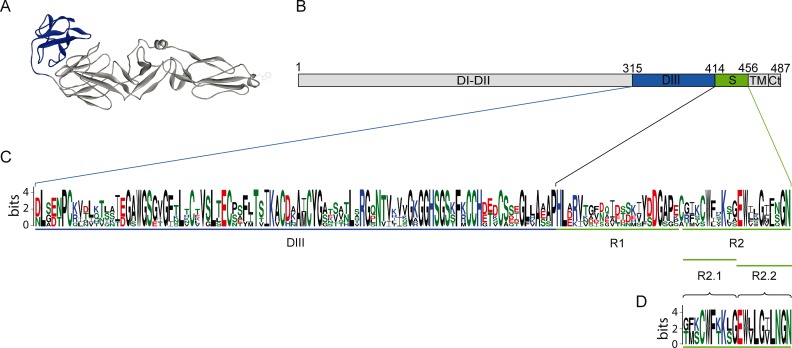
Localization of predicted DIII and stem fragments in ANDV Gc.(A) Molecular model for ANDV Gc in its pre-fusion conformation [23] based on the TBEV E protein (PDB: 1SVB) [31]. The predicted DIII is indicated in blue and the predicted domains I-II are shown in grey. (B) Scheme of the ANDV Gc primary structure indicating predicted residues for DIII (blue) and the predicted stem region (green). S indicates the stem region; TM indicates the transmembrane region; Ct indicates the cytoplasmic tail. (C) Sequence logo representation of a multiple sequence alignment including DIII and stem regions of the genus Hantavirus built with WebLogo [65]. The sequence conservation at each position is represented by the overall height of the stack at that position, while the conservation of a specific residue at that position is given by the height of the symbols. Acid residues are indicated in red, basic residues in blue, apolar residues in black and polar residues in green. For the multiple sequence alignment, glycoprotein sequences were retrieved from GenBank representing the four hantavirus phylogroups [66] from different reservoirs, including rodent-borne hantaviruses from the subfamiliies Avicolinae (PUUV; accession no. NP_941983.1), Murinae (HTNV; accession no. NP_941978.1), Sigmodontinae (ANDV; accession no. AAO86638.1), and also hantaviruses harbored in shrews, moles and bats from the families Soricidae (Thottapalayam virus; accession no. ABU82619.1), Talpidae (Asama virus; accession no. ACI28508.1), and Rhinolophidae (Longquan virus; accession no. AGI62348.1). The regions spanned by recombinant domains and peptides are indicated schematically below the logo representation by DIII, R1, R2, R2.1 and R2.2. (D) Sequence logo representation of a sequence alignment from the partial stem region of ANDV and PUUV Gc.